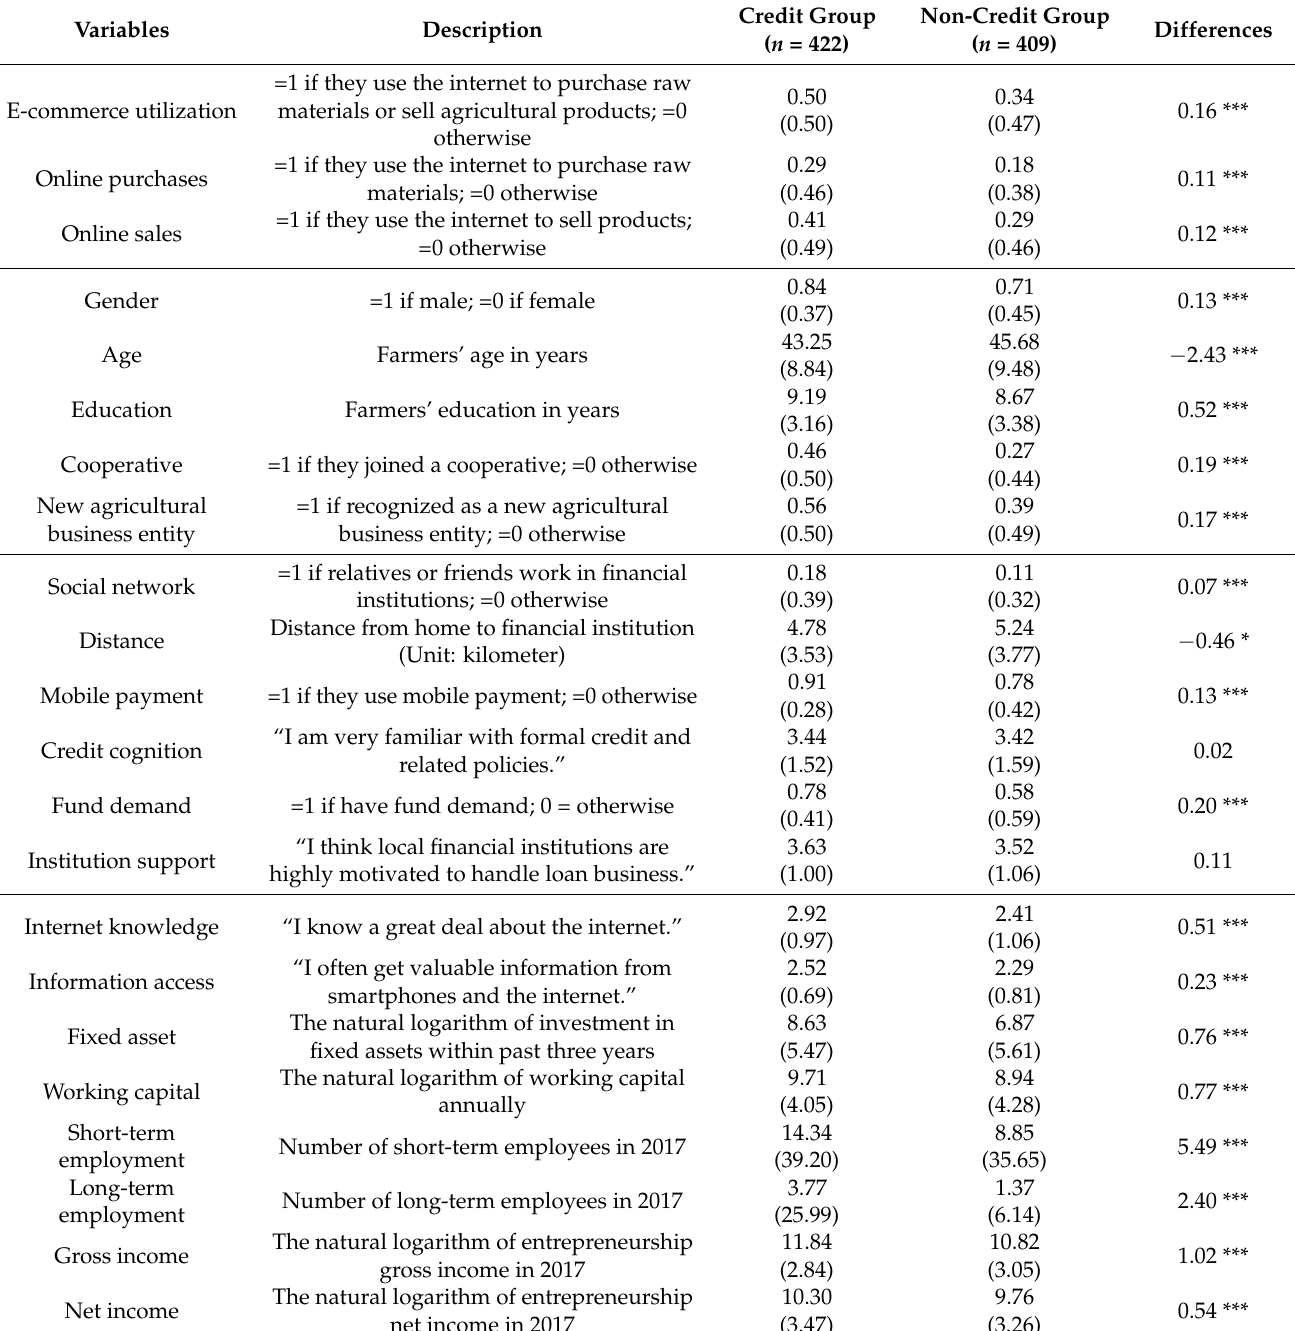
Table 1. Descriptions and summary statistics of variables, by formal credit participation